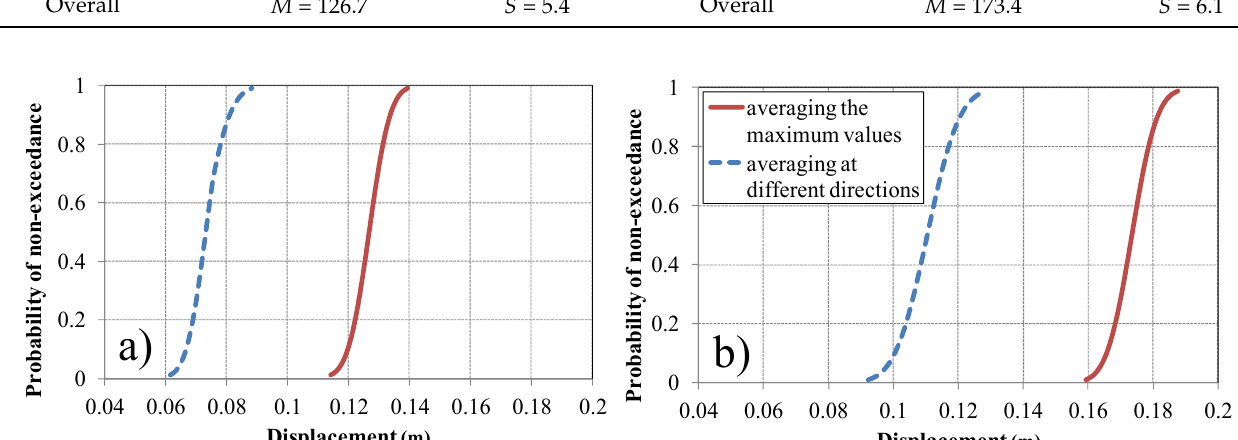
Figure 14. Probability of non-exceedance for the mean displacements of the central column using different averaging methods, due to variability of angle θ , for: ( a ) regular bridge; ( b ) irregular bridge.